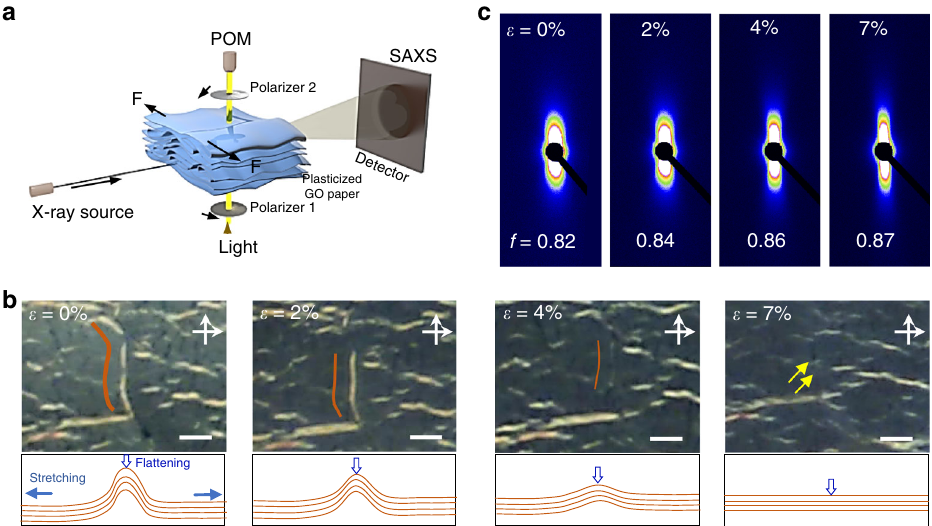
Fig. 3 Crystalline evolution during plasticization stretching of plasticized graphene oxide papers. a Schematic of real-time tracking of the structural change of the plasticized GOP during tension ( ε ). b , c POM images ( b ) and SAXS patterns ( c ) of the plasticized GOP at different ε . Scale bar, 50 μ m ( b